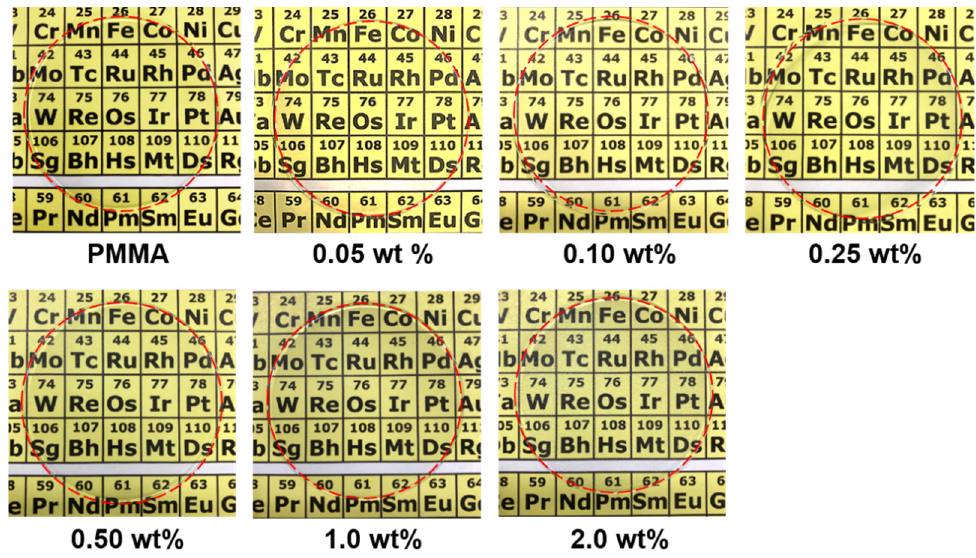
Figure 9. Photographic images of ~0.5-mm-thick PMMA composite sheets containing 0.05, 0.10, 0.25, 0.50, 1.0, and 2.0 wt% MPC 1, with neat PMMA as a reference, overlaid on the periodic table. The perimeter of each sheet is indicated by a red circle.